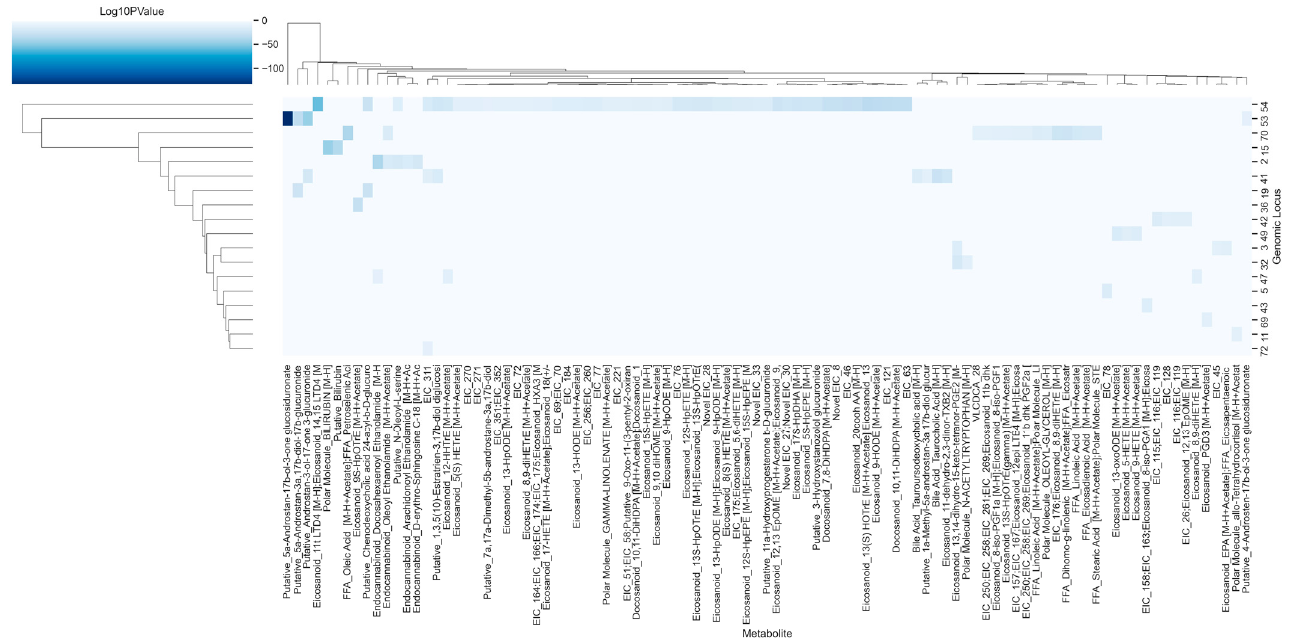
Figure 6. A total of 762 SNP-metabolite associations with identified metabolites were reported, with 18 unique genomic loci and 98 identified metabolites. Values in the heatmap represent the log of the p -value of each SNP-metabolite association, with a lower value indicating a stronger relationship between the genomic locus and the metabolite. For improved visualization, the identity of the metabolites in the x-axis has been shortened to include only the first 50 characters. The colorbar showing log-scaled p -values has been adjusted to improve visualization, and the highest values go beyond -100. The full names for each identified metabolite are present in Supplementary Table S4.